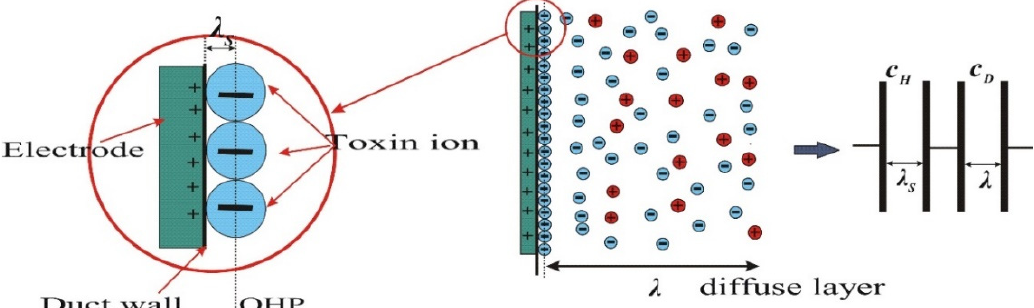
Figure 4. Configuration of the double layer and equivalent capacitor representation, OHP: Outer Helmholtz